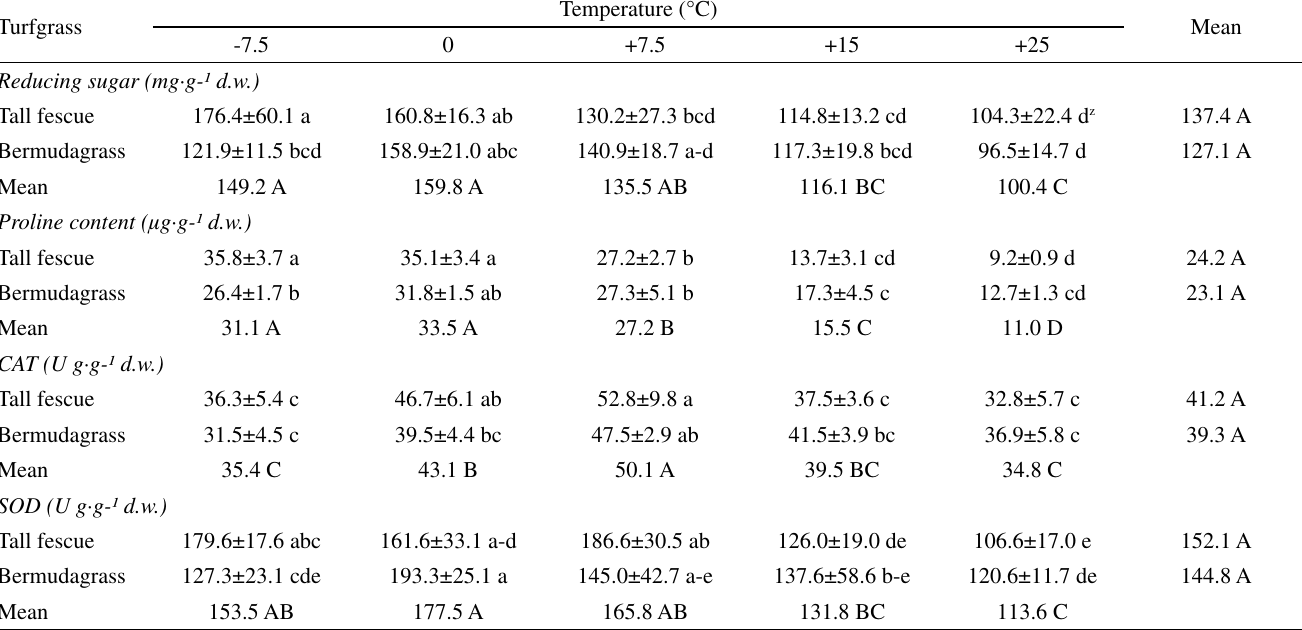
Table 1 - Effects of cold stress on biochemical changes [reducing sugar, proline content, catalase (CAT) and superoxide dismutase (SOD) activity] in the two turfgrasses used in this study Turfgrass